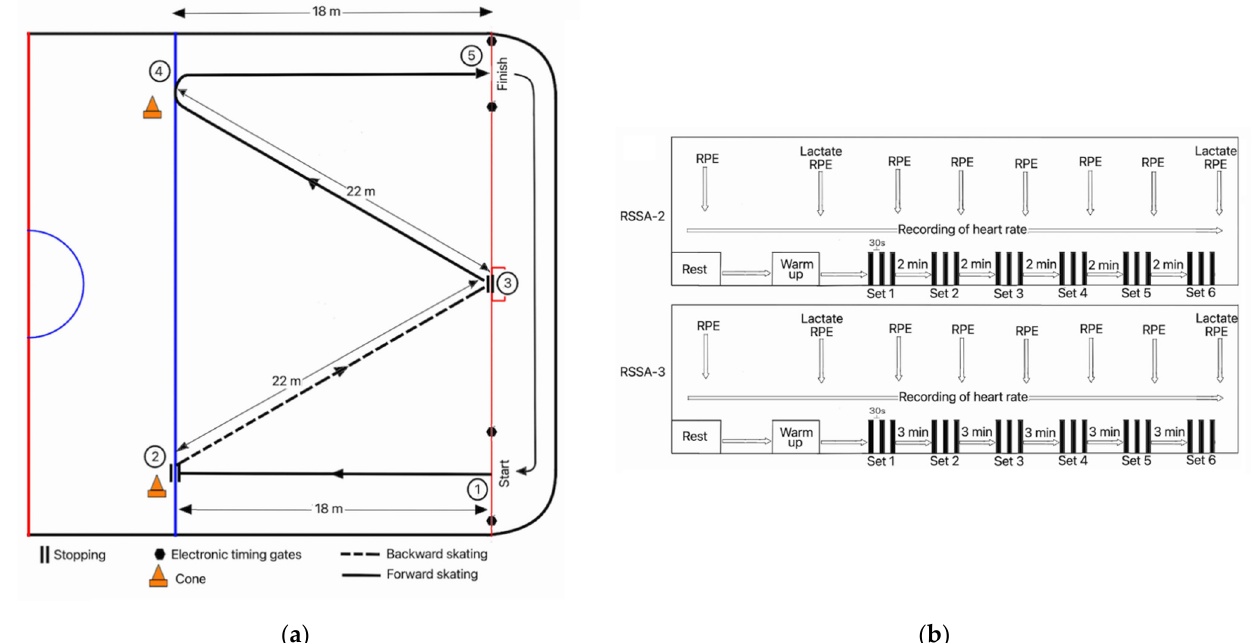
Figure 1. Study protocol. ( a ) Diagrammatic presentation of the direction and distance of skating in the repeated sprint skating ability test. ( b ) Schematic representation of the study protocol. This shows six sets of repeated sprint skating ability tests with two different passive rest period durations. (1) RSSA-2: Rest period of 2 min and (2) RSSA-3: Rest period of 3 min. Down arrows indicate time for collection of blood samples and recording of RPE. Heart rate was recorded continuously from rest until the end of the RSSA test.